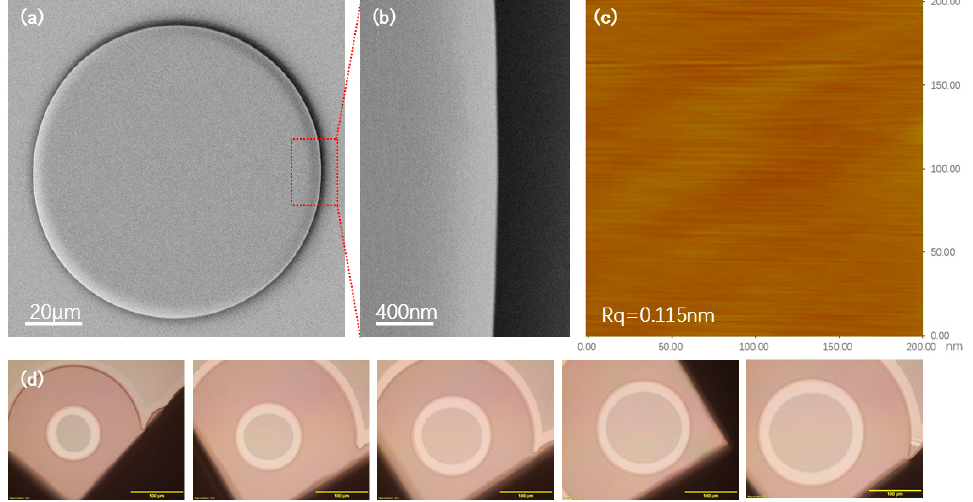
Figure 2. ( a ) Top view scanning electron microscope (SEM) image of a fabricated LN microdisk resonator. ( b ) Close up view SEM image of the area indicated by the red box in ( a ). ( c ) Atomic force microscope (AFM) image of the microdisk wedge. ( d ) Optical microscope image of the microdisk resonator with different diameters (55 μ m, 85 μ m, 105 μ m, 135 μ m, 155 μ m, 185 μ m, and 205 μ m).